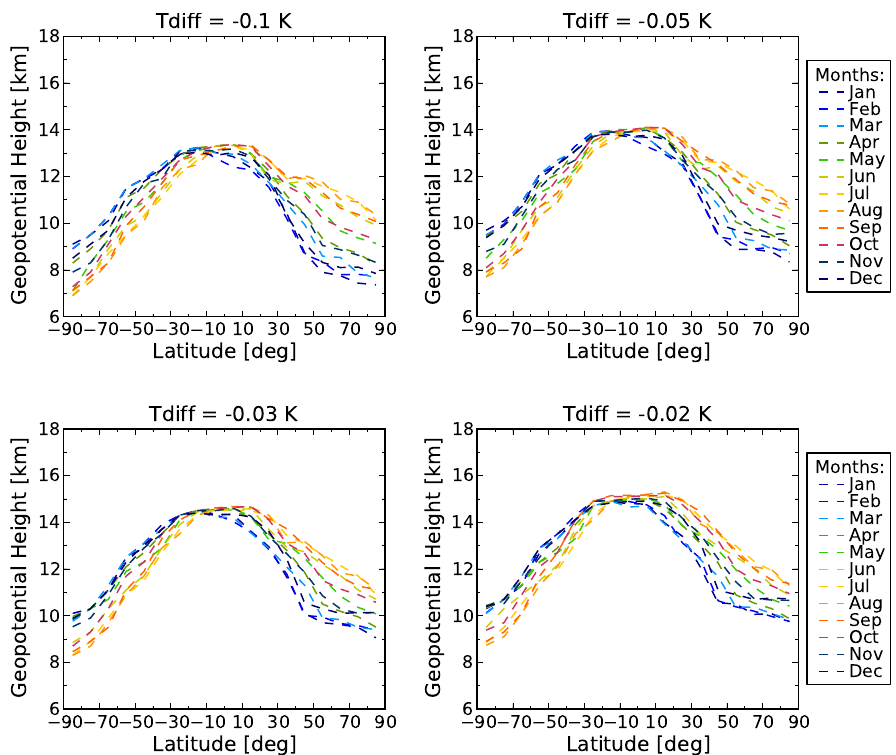
Figure 5. Calculated minima (dashed lines) from 2006 to 2010 of T diff = − 0 . 1, − 0 . 05, − 0 . 03, and − 0 . 02 K, for every